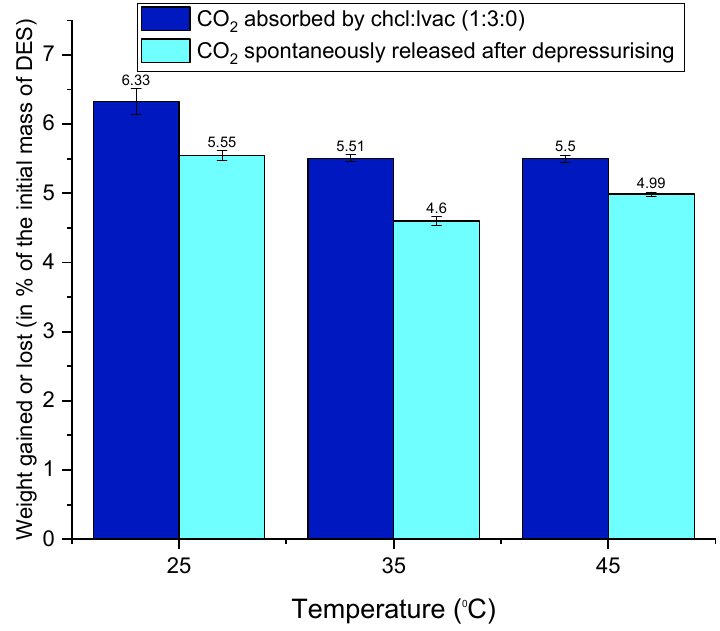
Figure 9. Weight gained by ChCl:LvAc (1:3:0) after CO 2 absorption at 25 °C, 35 °C and 45 °C and lost by CO 2 released spontaneously after depressurisation.